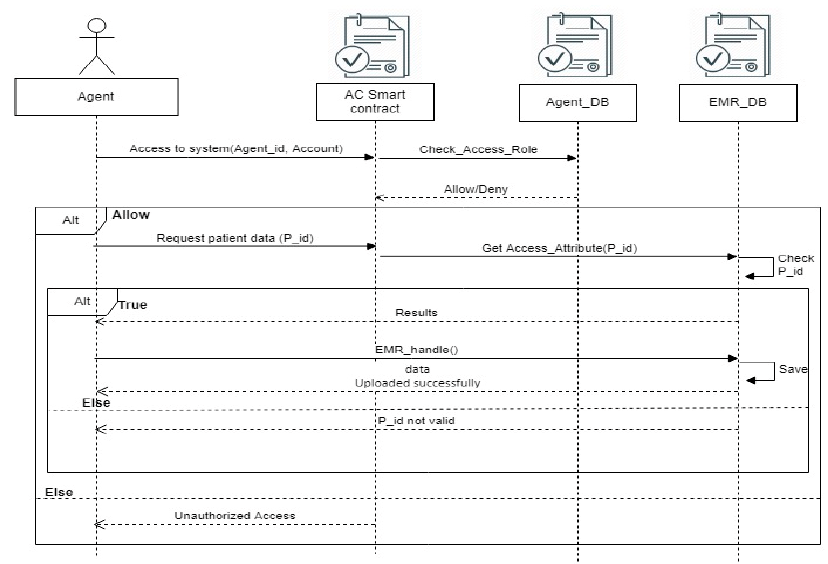
Figure 6. EMR management Based RBAC and ABAC.